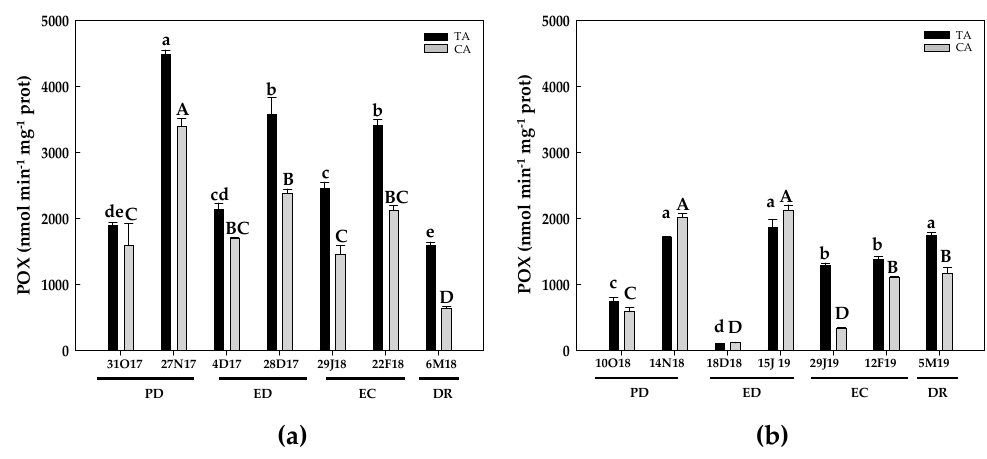
Figure 13. Evolution of peroxidase (POX) activity in flower buds of peach ‘GEM020’ cultivated in two different geographical areas during the dormancy cycle on two seasons. ( a ): season 1 (2017–2018); ( b ): season 2 (2018–2019). Data represent the mean ± SE, n = 5. Different letters (lowercase and uppercase for the samples of the temperate (TA) and the cold area (CA), respectively) indicate significant differences according to Tukey’s multiple test ( p ≤ 0.05). PD: paradormancy; ED: endodormancy; EC: ecodormancy; DR: dormancy release. FW: fresh weight. The chill units accumulated at the different times and locations are shown in Supplemental file 1.